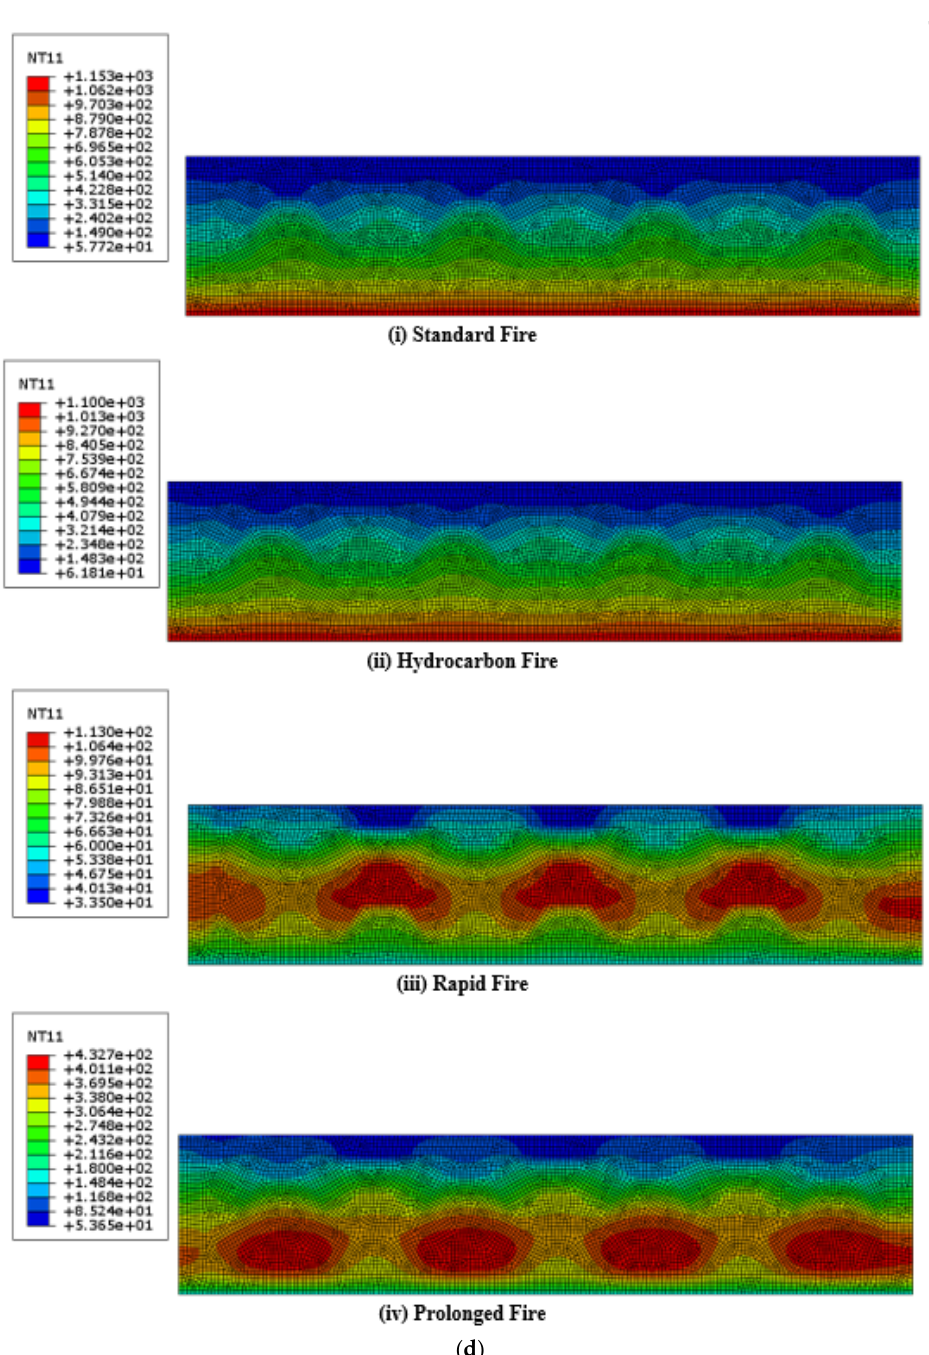
Figure 15. ( a ) Temperature distribution of C6 100 wall panel. ( b ) Temperature distribution of CI6 100 wall panel. ( c ) Temperature distribution of C6 200 wall panel. ( d ) Temperature contours of CI6 200 wall panel.